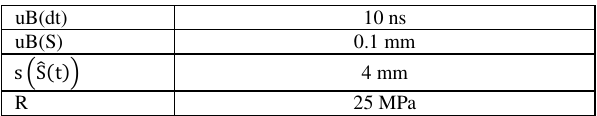
Table 2. Basic assumptions for the observation method uncertainty evalua-